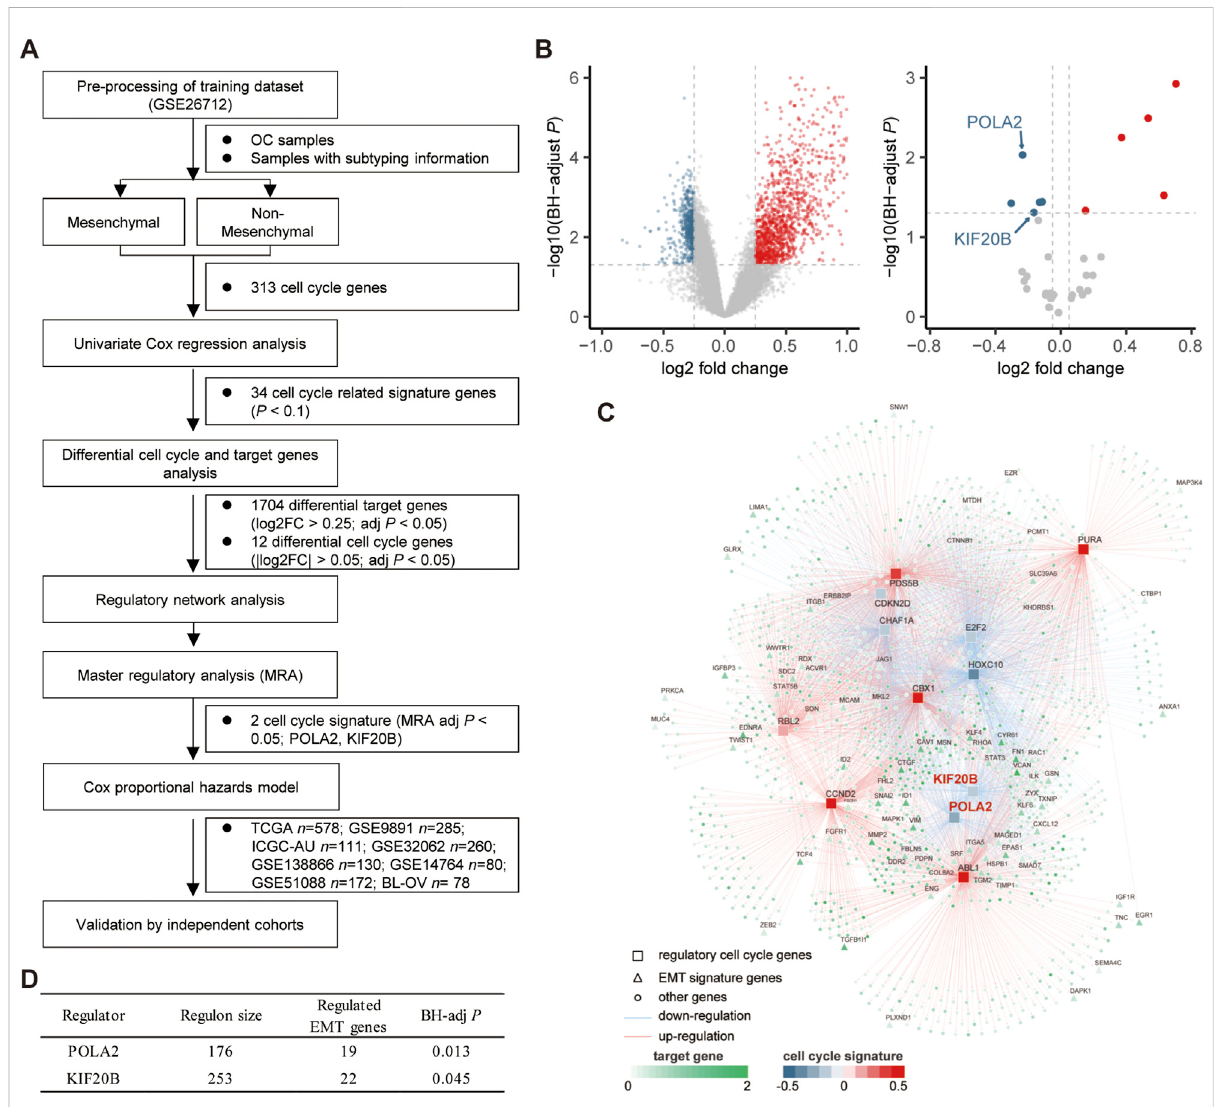
FIGURE 1 Networkinferenceidenti fi edtwocyclesignaturegenes(POLA2andKIF20B) asthekeyregulators inthemesenchymalsubtypeofOC. (A) Study design of the present work. (B) Volcano plot of the differentially expressed target genes and cell cycle signature genes in the mesenchymal subtype. (C) Integrated network showing the relationships between the expression data of the cell cycle signature genes and target genes. (D) Master regulator analysis